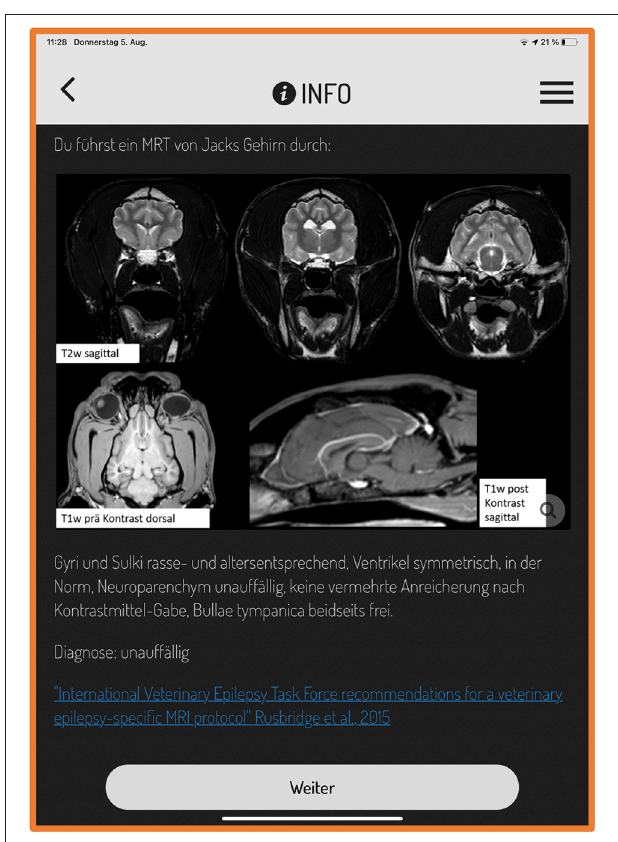
FIGURE 2 | Original screenshot of actionbound. The screen displays the magnetic resonance imaging (MRI) results of a Labrador Retriever with seizures and a link to an international consensus statement about epilepsy-specific MRI protocols. (Text says: “You performed a MRI of Jack’s brain:”; “T2w sagittal”; “T1w pre contrast dorsal”; “T1w post contrast sagittal”, “Gyri and sulci breed and age specific normal. Ventricles symmetrical, normal, brain parenchyma unremarkable, no pathological contrast uptake, tympanic bulla both sides filled with air.”; “next”). T2w, T2 weighted; T1w, T1